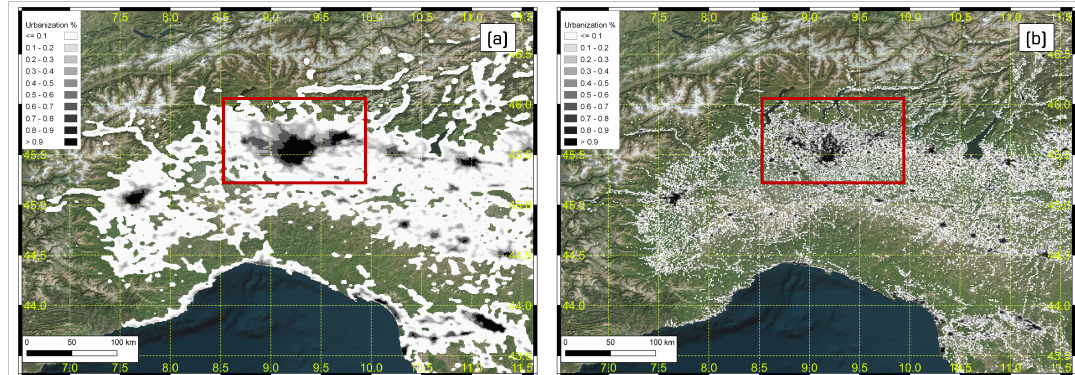
Figure 6. Comparison between estimated and original urban density mapping (from 0 in white to 1 in black) for North-West Italy ( a ) obtained applying the calibration curve on DMSP night-time light series (30 arc seconds, 2011), ( b ) derived from normalization of the GUF map by DLR (12 m, 2011–2012); Milan area is squared in